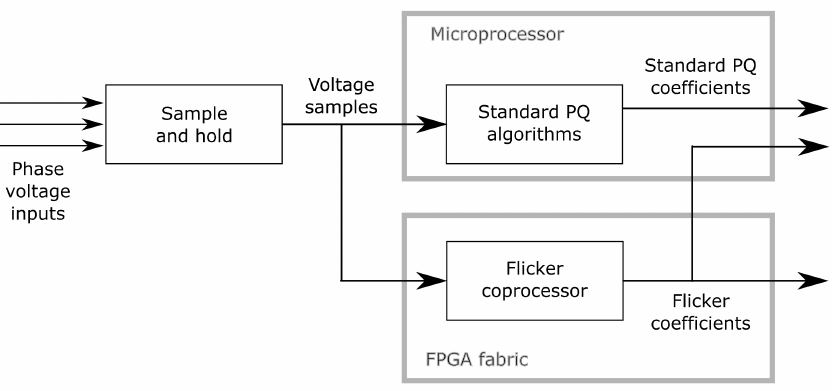
Figure 1. Configuration of a flickermeter as a part of a PQ measurement